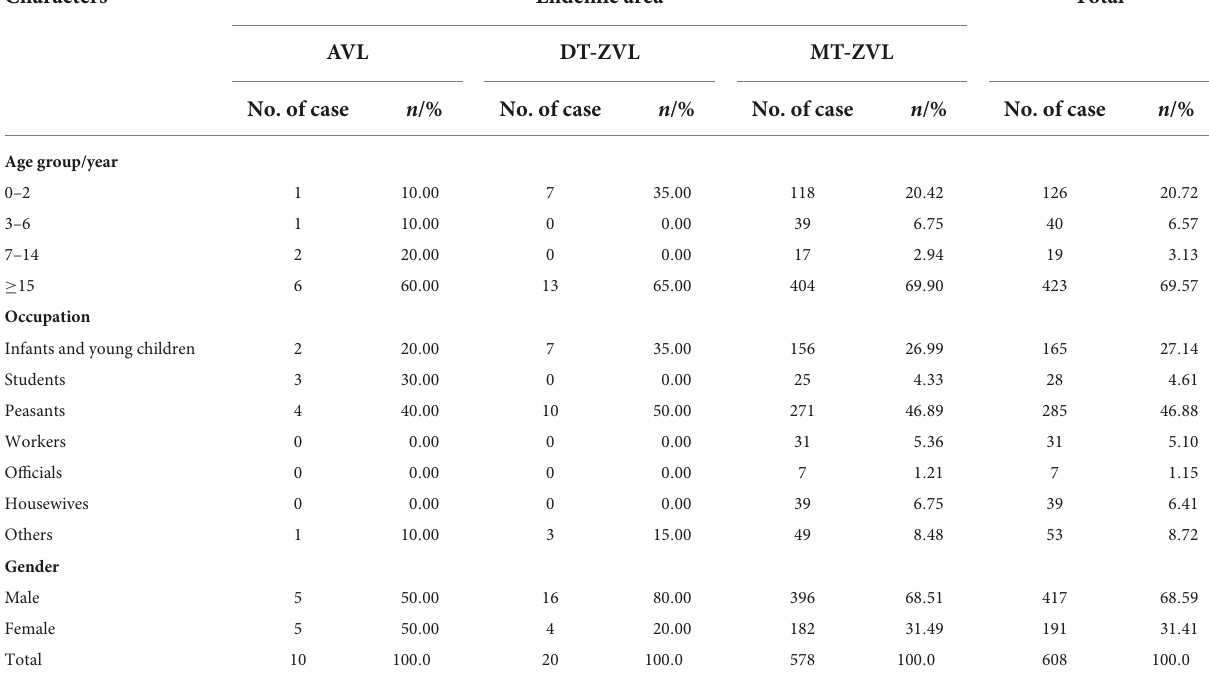
TABLE 2 Demographic distribution of visceral leishmaniasis cases in China between 2019 and